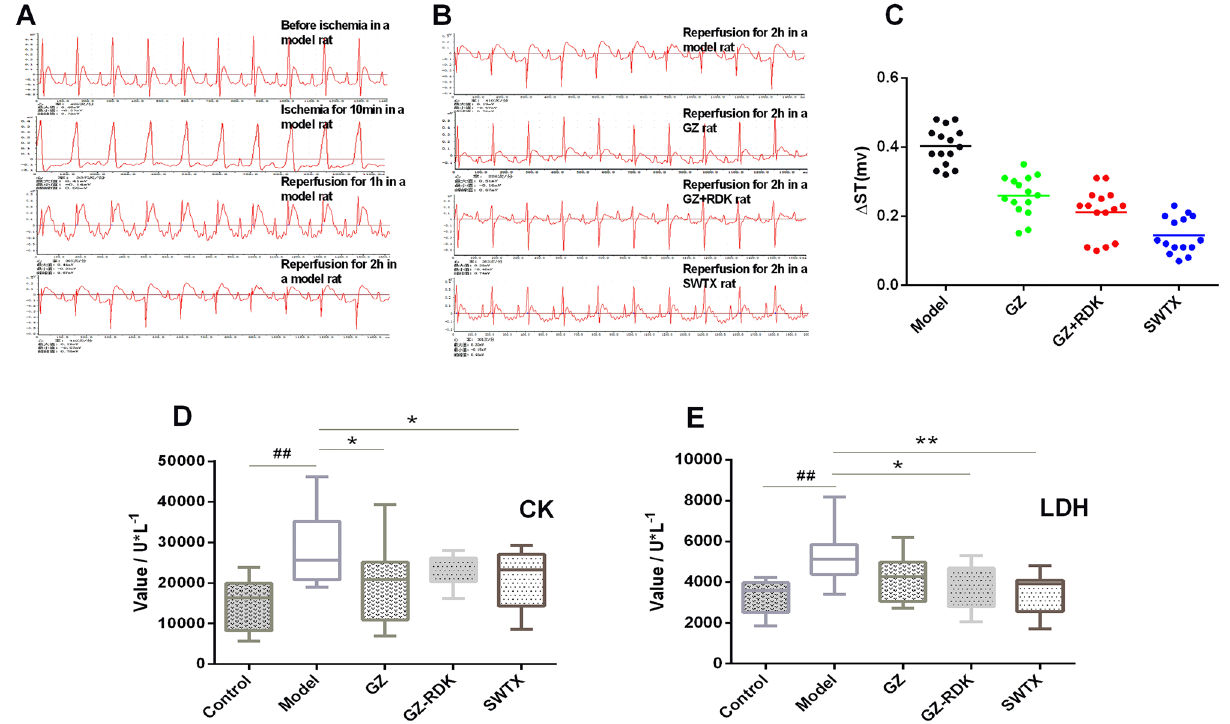
Figure 1. SWTX treatment reduced the severity of myocardial ischemia. ( A ) The typical electrocardiograms (ECG) of model rats at each node. ( B ) The typical electrocardiograms (ECG) of treatment groups after reperfusion for 2 h. ( C ) ST alteration value of each group (∆ST). ( D ) The level of LDH. ( E ) The level of CK. Values are mean ± SD ( n = 15 in each group). ## P < 0.01 versus control group; ** P < 0.01 versus model; * P <